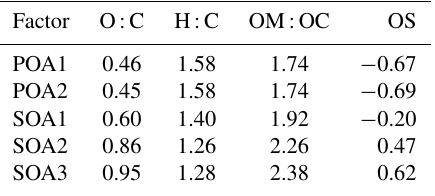
Table 6. Elemental composition of the PMF factors POA1, POA2, SOA1, SOA2 and